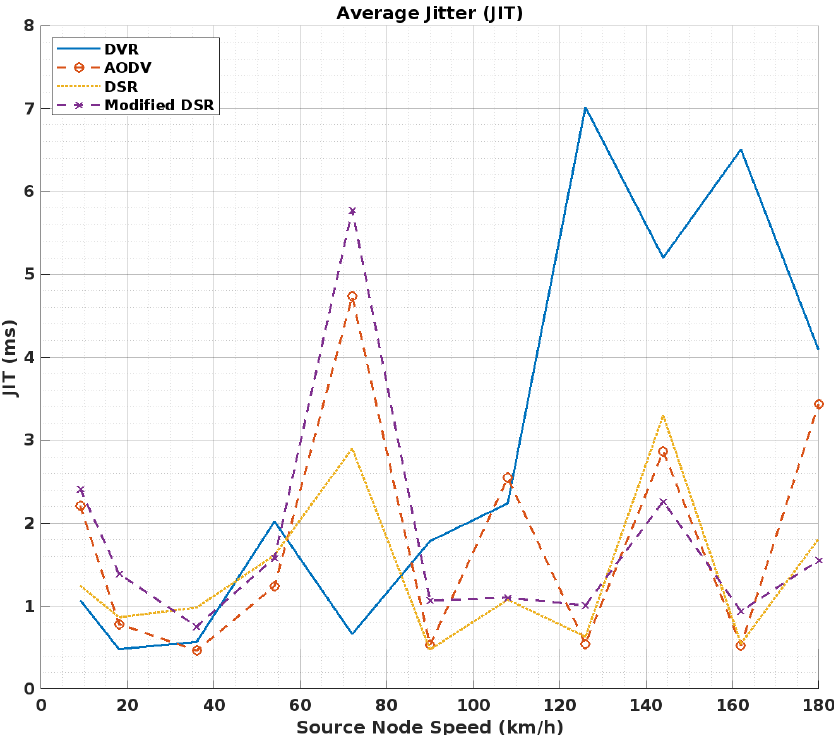
Figure 6. Average Jitter (JIT) as a function of the source node’s speed for the DVR, AODV, DSR, and Modified DSR